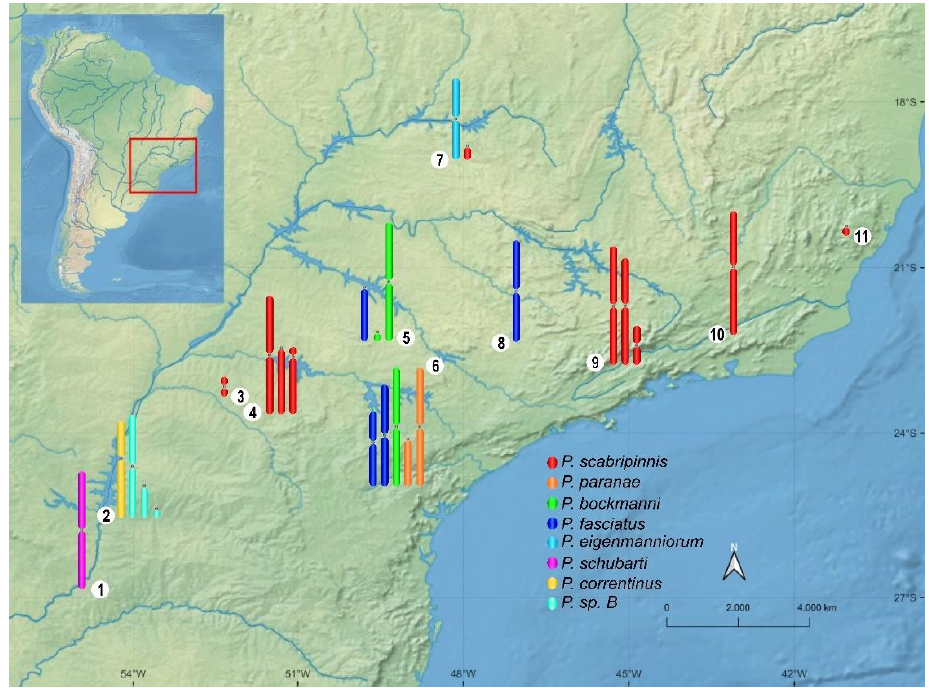
Figure 1. B chromosome diversity and distribution of Psalidodon species. 1 — Missiones. 2 — Foz do Iguaçu. 3 — Maringá. 4 — Marialva. 5 — Bauru. 6 — Botucatu. 7 — Uberlândia. 8 — Araras. 9 — Campos